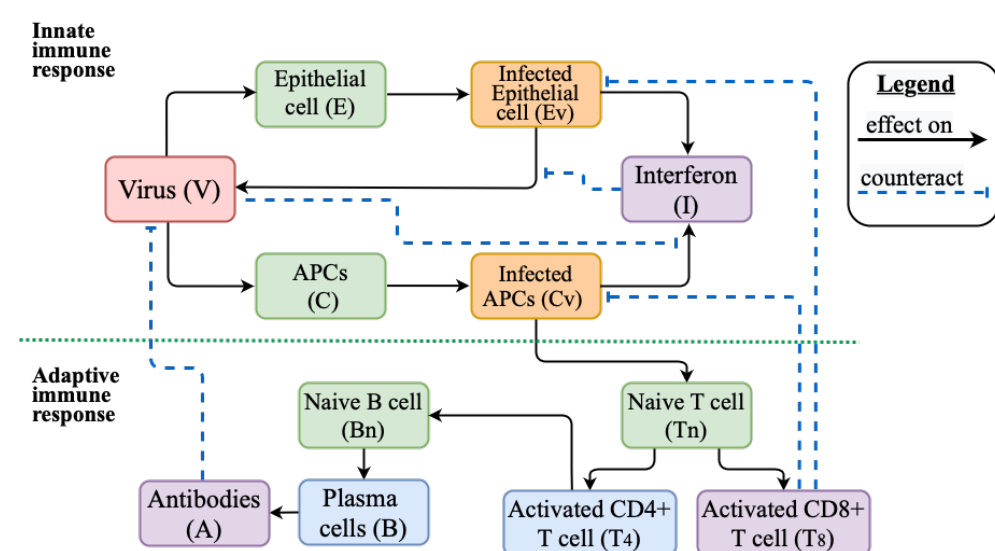
Figure A2. Schematic representation of the innate and adaptive immune responses to respiratory viral infection. Green boxes indicate cells with constant presence in the organism. Orange boxes note virus-affected cells. Blue boxes represent the cells responsible for stimulating the specific immune response. Violet boxes show effectors of innate and adaptive immune response.